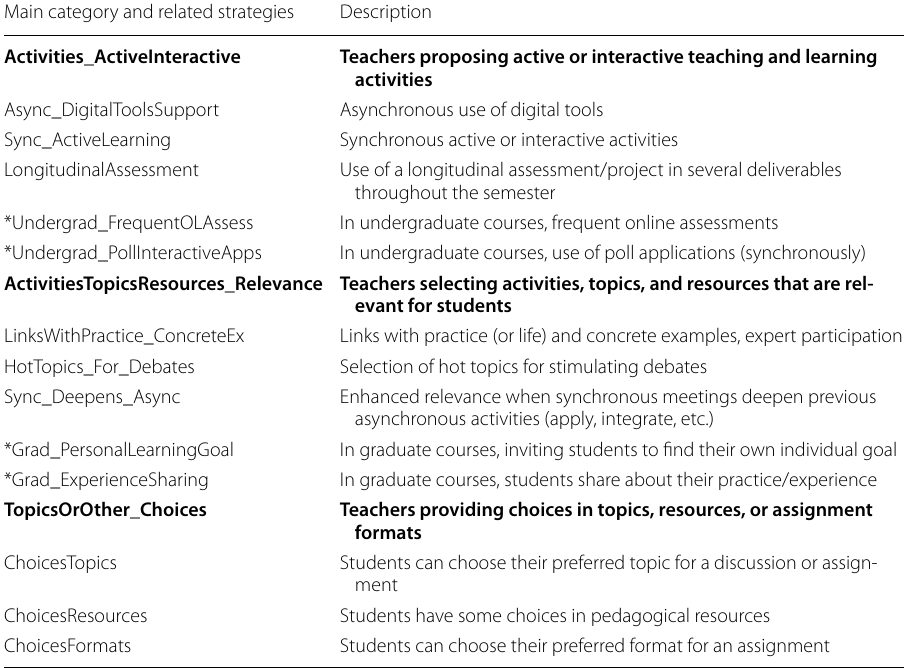
Table 4 Meta-category: selection of teaching and learning activities